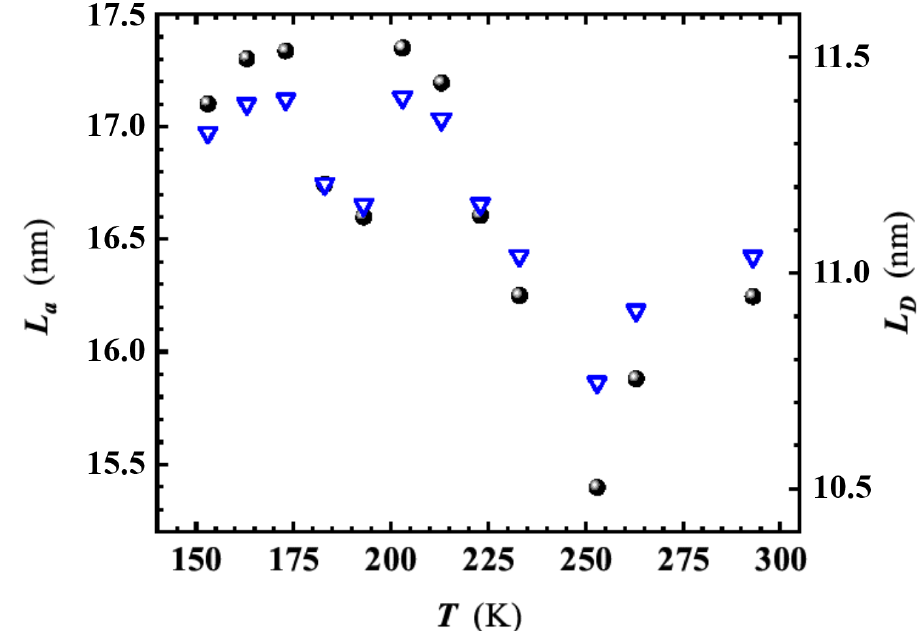
Figure 7. Temperature dependence of crystallites size, L a , (dots) and distance between defects, L D , (reversed triangles) in the investigated graphene sponge. L a and L D have been derived by using Equations (1) and (2), respectively. For the calculation, the Raman I D / I G peak intensity ratio of the components at 1327 cm − 1 ( D -peak) and 1578 cm − 1 ( G -peak), respectively have been